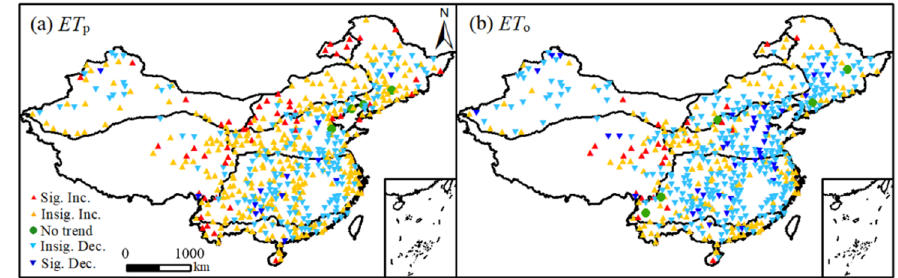
Figure 9. The trends and significance of annual ET p and ET o in mainland China.